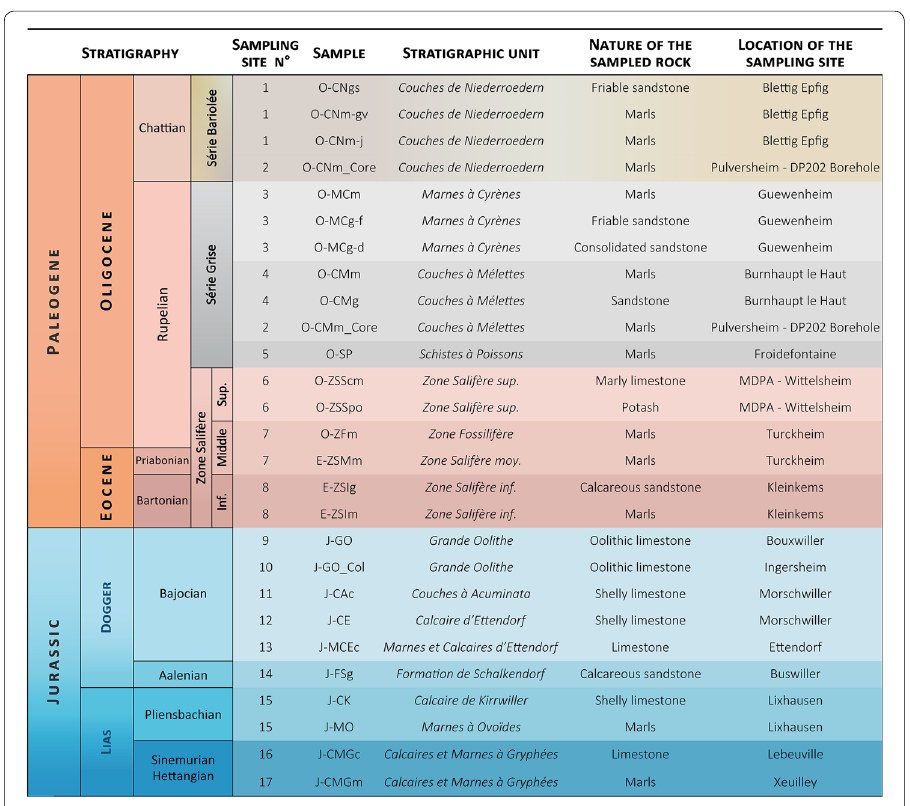
Fig. 2 List of Tertiary and Jurassic samples classed in stratigraphic order. Lithostratigraphic unit, number of the sampling site (see Fig. 1 for location on the map), nature of the sampled rock and location of the sampling site are